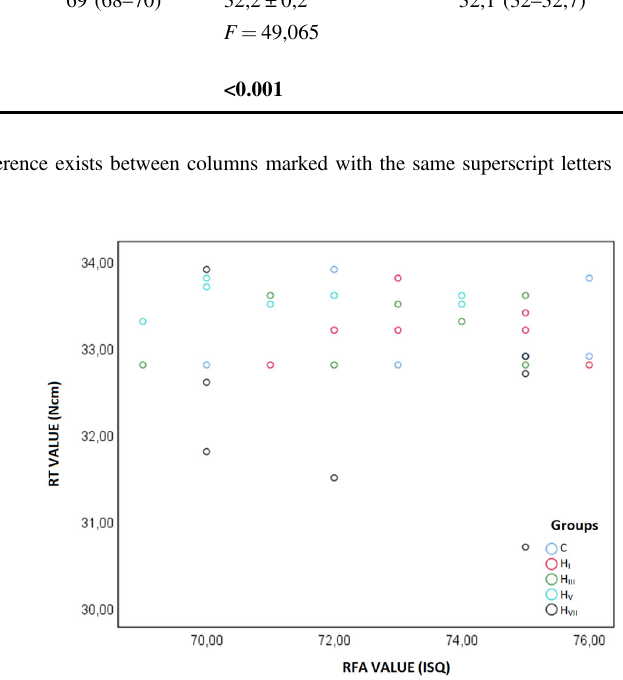
Table 2 Comparison of groups for second RFA and RT values